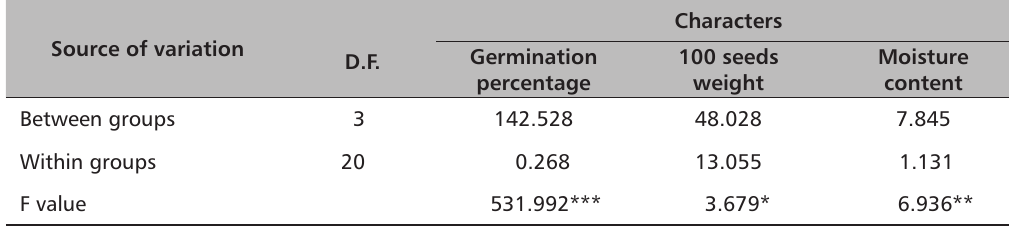
TABLE 3. The result of ANOVA for exposure factor on seed of Oriental beech